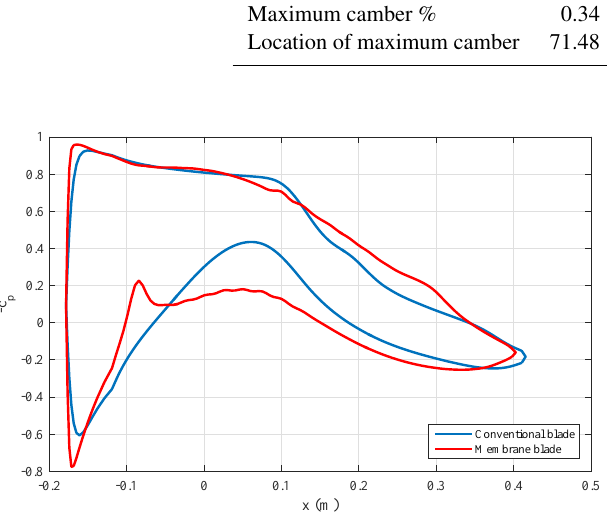
Table 7. Maximum camber and its location for the middle span section of the second segment from the root. α (deg) 0 . 0